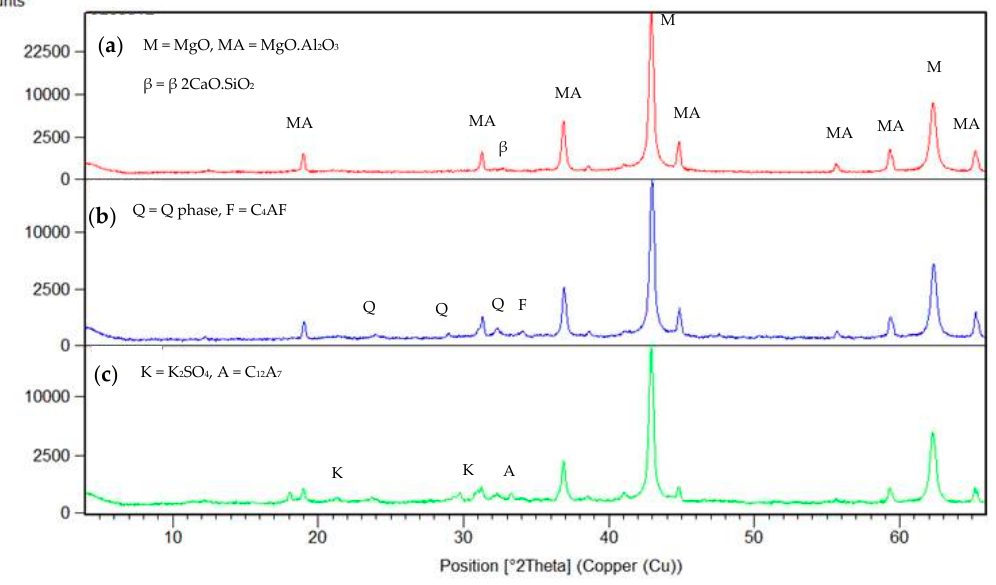
Figure 5. Visual aspect and cross section of the bricks A and B after 3 cycles of contact coating test using modified cement raw meal.